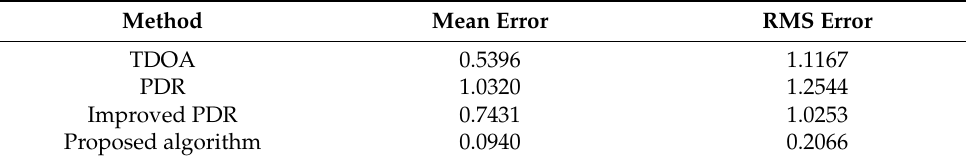
Table 3. Comparison of localization accuracy with different algorithms (m) (Second scene).